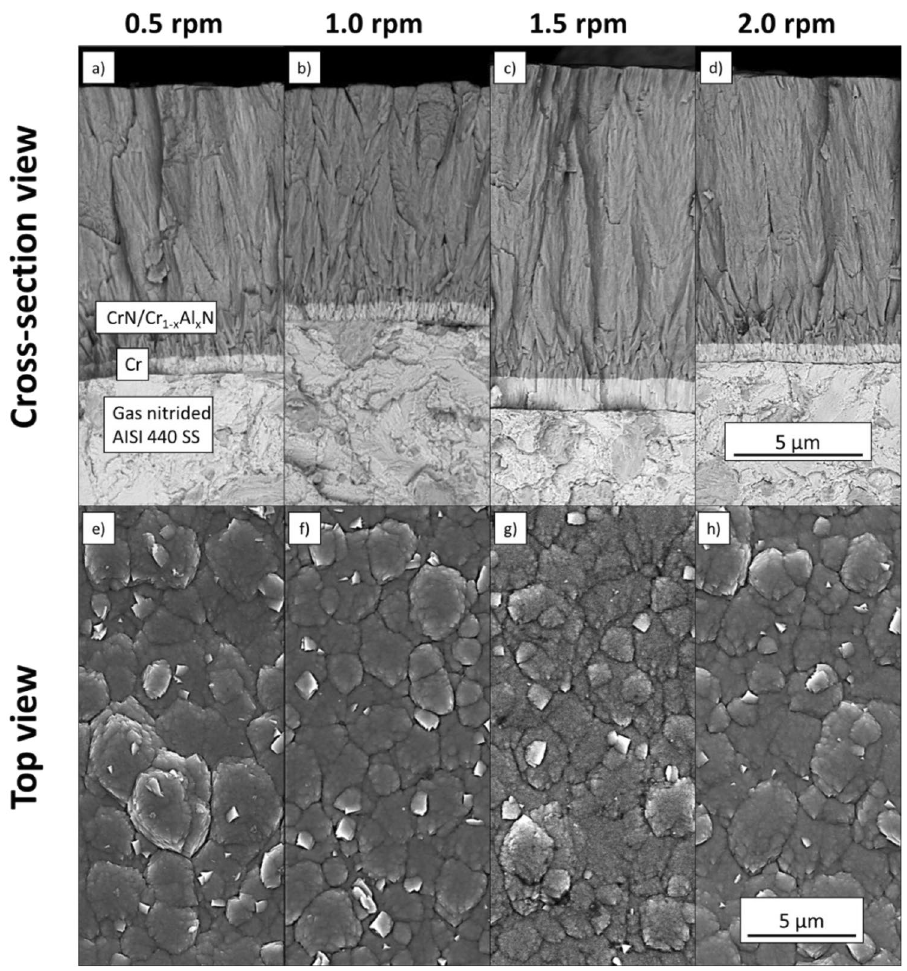
Figure 7. ( a – h ) FEG-SEM micrographs of fractured cross-sections ( a – d ) and top surfaces ( e – h ) acquired from